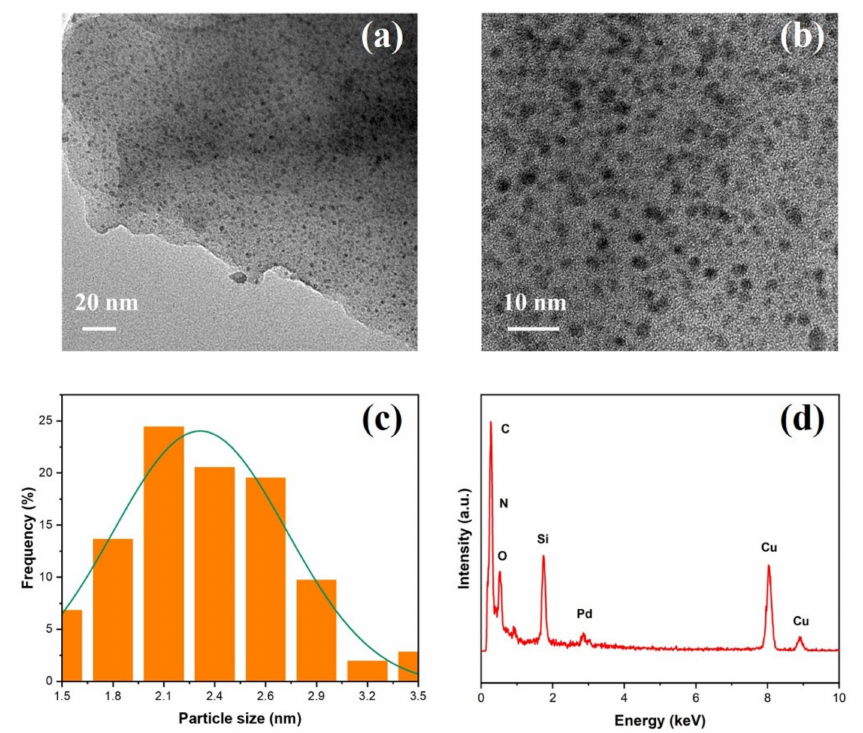
Figure 4. ( a , b ) TEM images, ( c ) size distribution of the in situ formed palladium nanoparticles, and ( d ) EDX spectrum of the Du1800-Pd precursor. Cu signals come from the copper